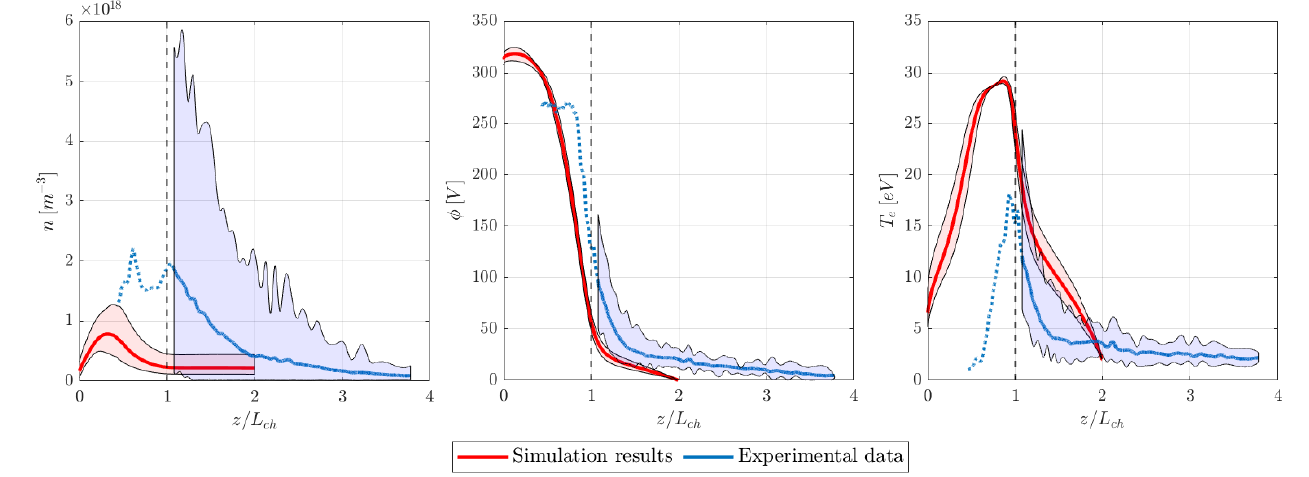
Figure 9. Comparison between simulation results and experimental data in the channel and near-plume for the intensive plasma properties: ( left ) plasma density; ( middle ) plasma potential; ( right ) electron temperature. Solid lines represent the time-averaged values, while the shaded areas envelope the local oscillations of the various properties. Note that the experimental data were reported only in the region where the probe was not perturbing the flow. For the perturbed region, only the average value is reported with a dashed line for a qualitative